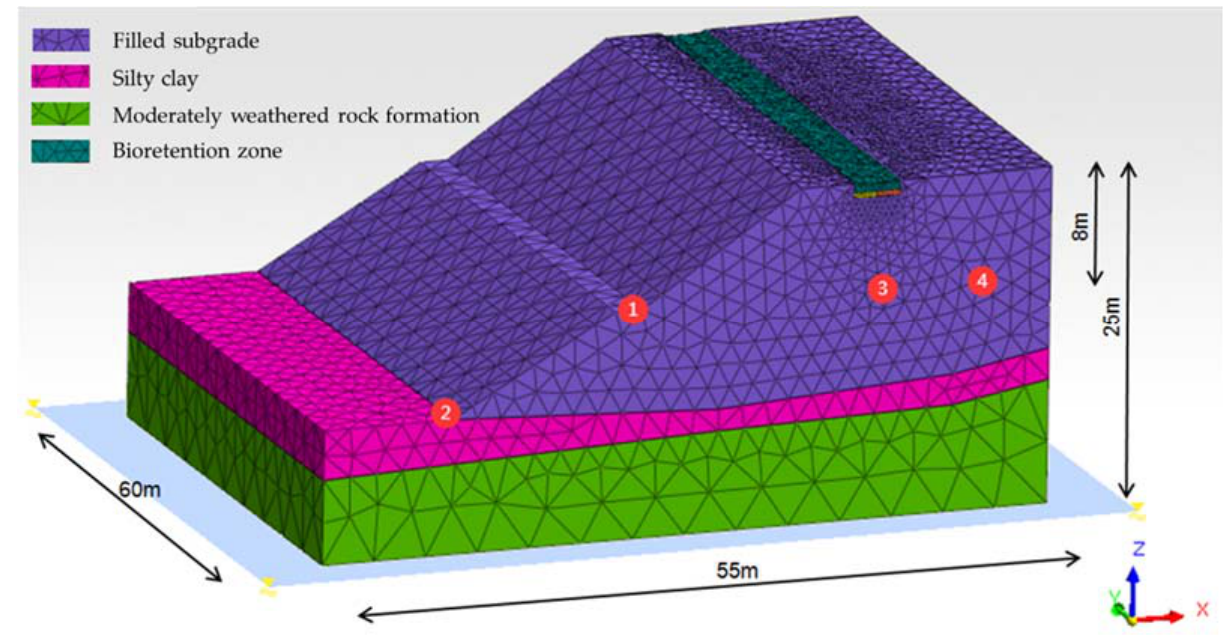
Figure 2. Finite element mesh model used in this study, 1–4 in the figure indicates the control points in the model.